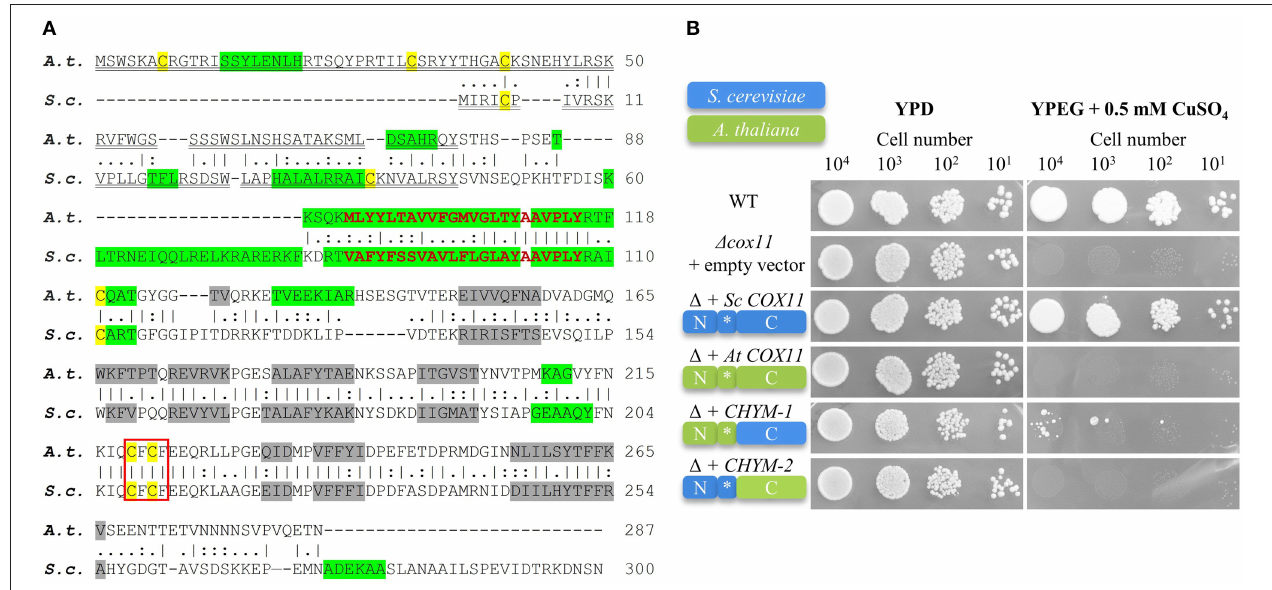
FIGURE 1 | The Arabidopsis COX11 homolog shares structural and sequence similarities with yeast COX11, but cannot functionally complement it. (A) The A. thaliana (A. t.) and S. cerevisiae (S. c.) protein sequence were retrieved from the GenBank database and aligned. The vertical lines (I) indicate identical residues between the two sequences, while the colons (:) and periods (.) represent conservative substitutions with strongly and weakly similar properties, respectively. Cysteines are labeled yellow. The putative copper-binding motifs are boxed. The predicted cleavable N-terminal targeting signals are double underlined. The predicted transmembrane domains are shown in bold red letters, while the predicted α -helices and β -sheets are highlighted in green and gray, respectively. (B) Results from a respiratory competence test of yeast ∆ cox11 stains moderately overexpressing either full-length S. cerevisiae COX11 , Arabidopsis COX11, or sequences encoding the chimeric proteins CHYM-1 or -2. Schematic diagrams of the proteins depict their composition (N, N-terminal region; C, C-terminal region; * , transmembrane domain) and the origin of the respective regions ( S. cerevisiae , blue; A. thaliana, green). Serial dilutions of yeast strains were spotted on fermentable glucose media (YPD) or respiratory media (YPEG, ethanol + glycerol media supplemented with 0.5mM CuSO 4